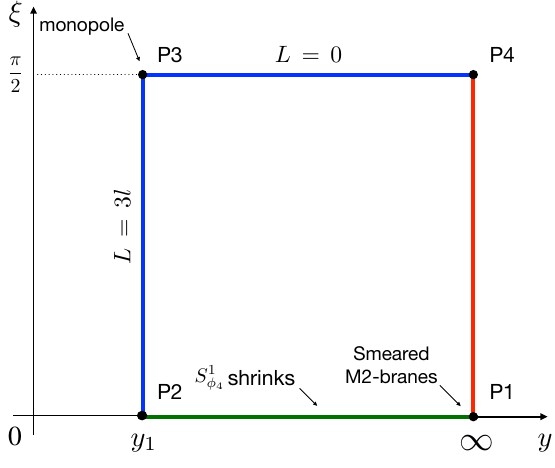
Figure 2 . The two-dimensional base space, B 2 , spanned by y and ξ